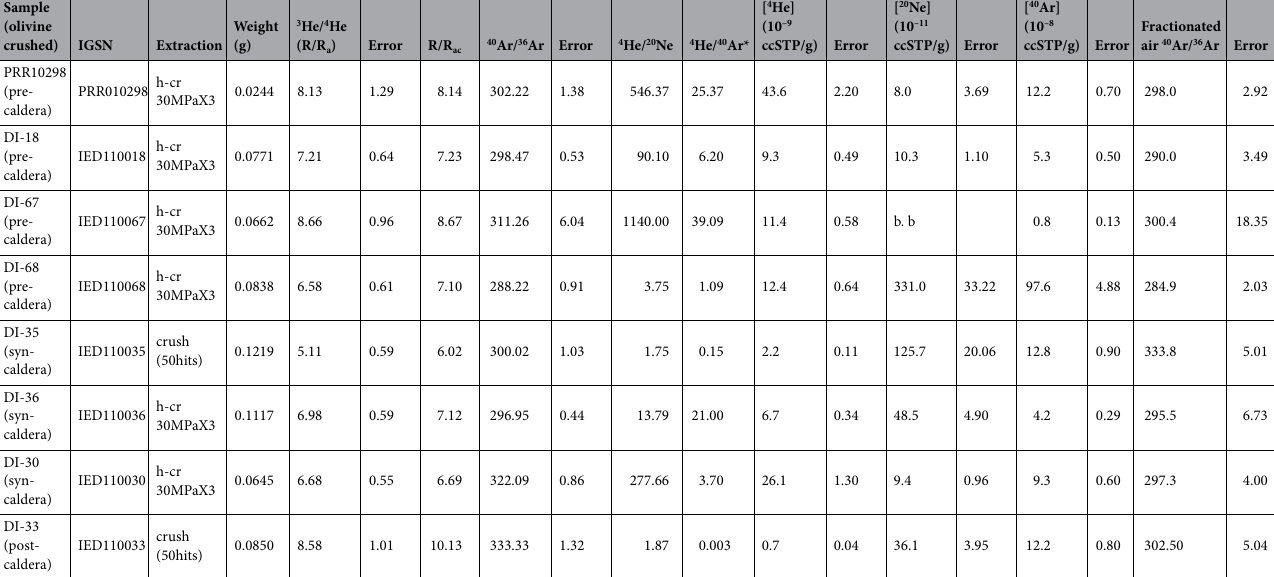
Table 1. Isotopic data of noble gases in the inclusions hosted in olivine phenocrysts (uncertainties are 1σ) (h-cr: hydraulic crushing; b.b: below blank). Fractionated air or initial 40 Ar/ 36 Ar = ( 38 Ar/ 36 Ar sample